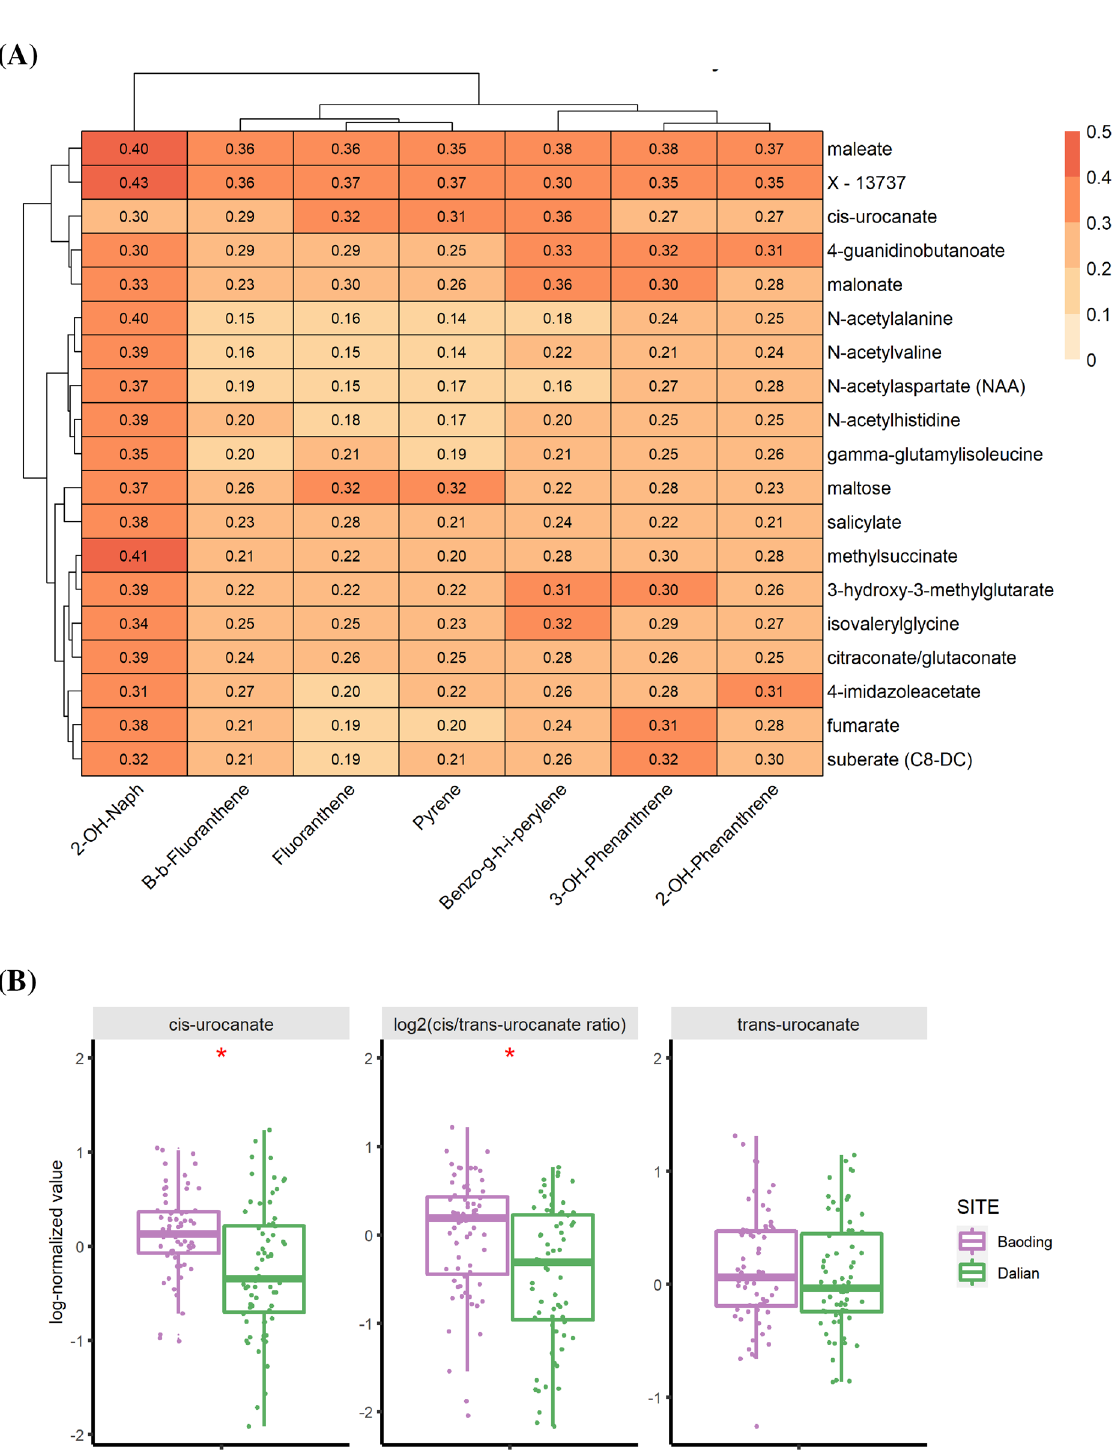
Figure 4. ( A ) Heatmap of cross-correlation between metabolites and PAHs selected by sparse Canonical Correlation Analysis (sCCA). The values in the heatmap correspond to Pearson’s correlation coefficient. ( B ) Focus on cis-and trans-urocanate metabolites with boxplots of the log-normalized values. We also represent the cis/trans urocanate ratio. A red star indicates that the difference in mean between the 2 cities, Baoding (More Polluted) and Dalian (Less Polluted), is significant (q-value < 0.05, t-test withcorrection for multiple testing using Benjamini–Hochberg method). Figures were created using the R software: R Core Team (2017), R Foundation for Statistical Computing, Vienna, Austria. URL https:// www.R- proje ct.